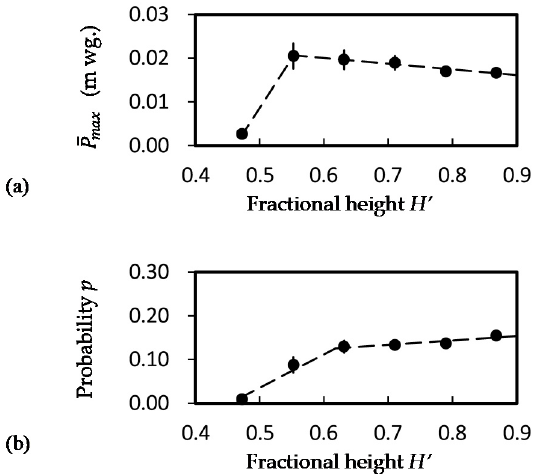
Figure 6. Measured quantity at a fractional height H’ of a discharging stack. (a) Average maximum air pressure 𝑃(cid:3364) (cid:3040)(cid:3028)(cid:3051) ; (b) probability p